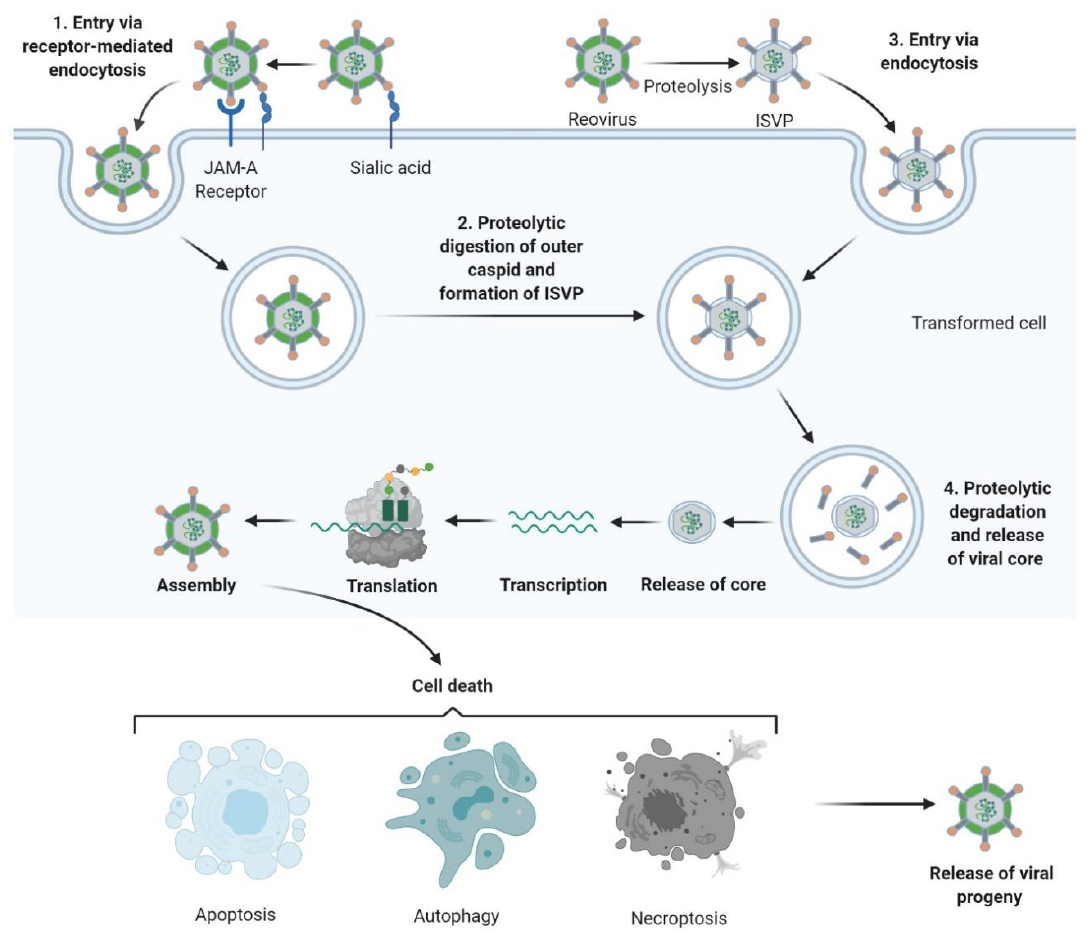
Figure 1. Reovirus replication: 1 . Reovirus is first tethered via a weak interaction between σ1 and cell surface sialic acid; σ1 then binds with high affinity to junctional adhesion molecule A (JAM-A) resulting in internalization of the virus via receptor-mediated endocytosis. 2. Once internalized, the virus is transported to early and late endosomes where it undergoes proteolytic digestion to remove the outer capsid protein σ3 resulting in the formation of infectious subvirion particles (ISVPs). 3. Alternatively, ISVPs may be formed by extracellular proteases within the tumour environment allowing direct entry into cells via membrane penetration. 4. After further proteolytic degradation a transcriptionally active viral core is released into the cytoplasm. Transcription and translation occur ultimately leading to the assembly of new viral progeny, host cell death and progeny release. Figure created using Biorender (https://biorender.com/).